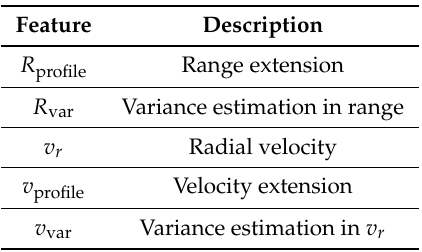
Table 1. Feature